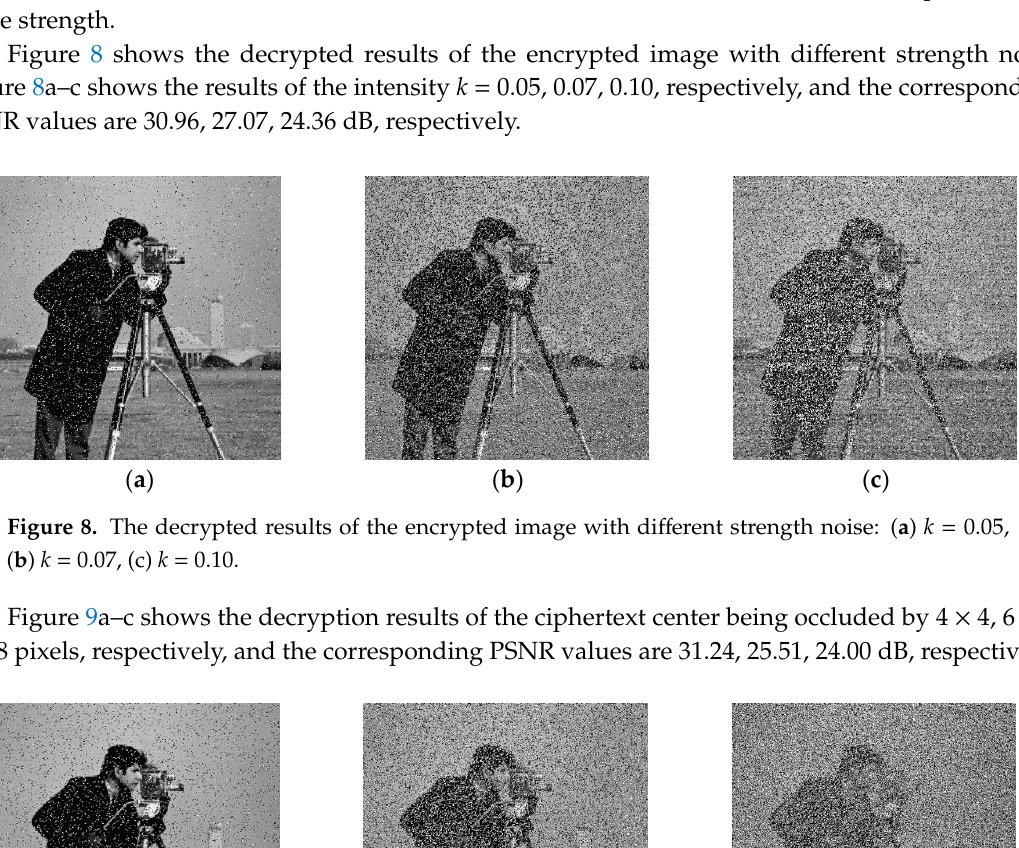
Figure 10. Decryption results of chosen-plaintext attack without key ( a ) R, ( b ) r, ( c ) λ , ( d ) 2D kernel.